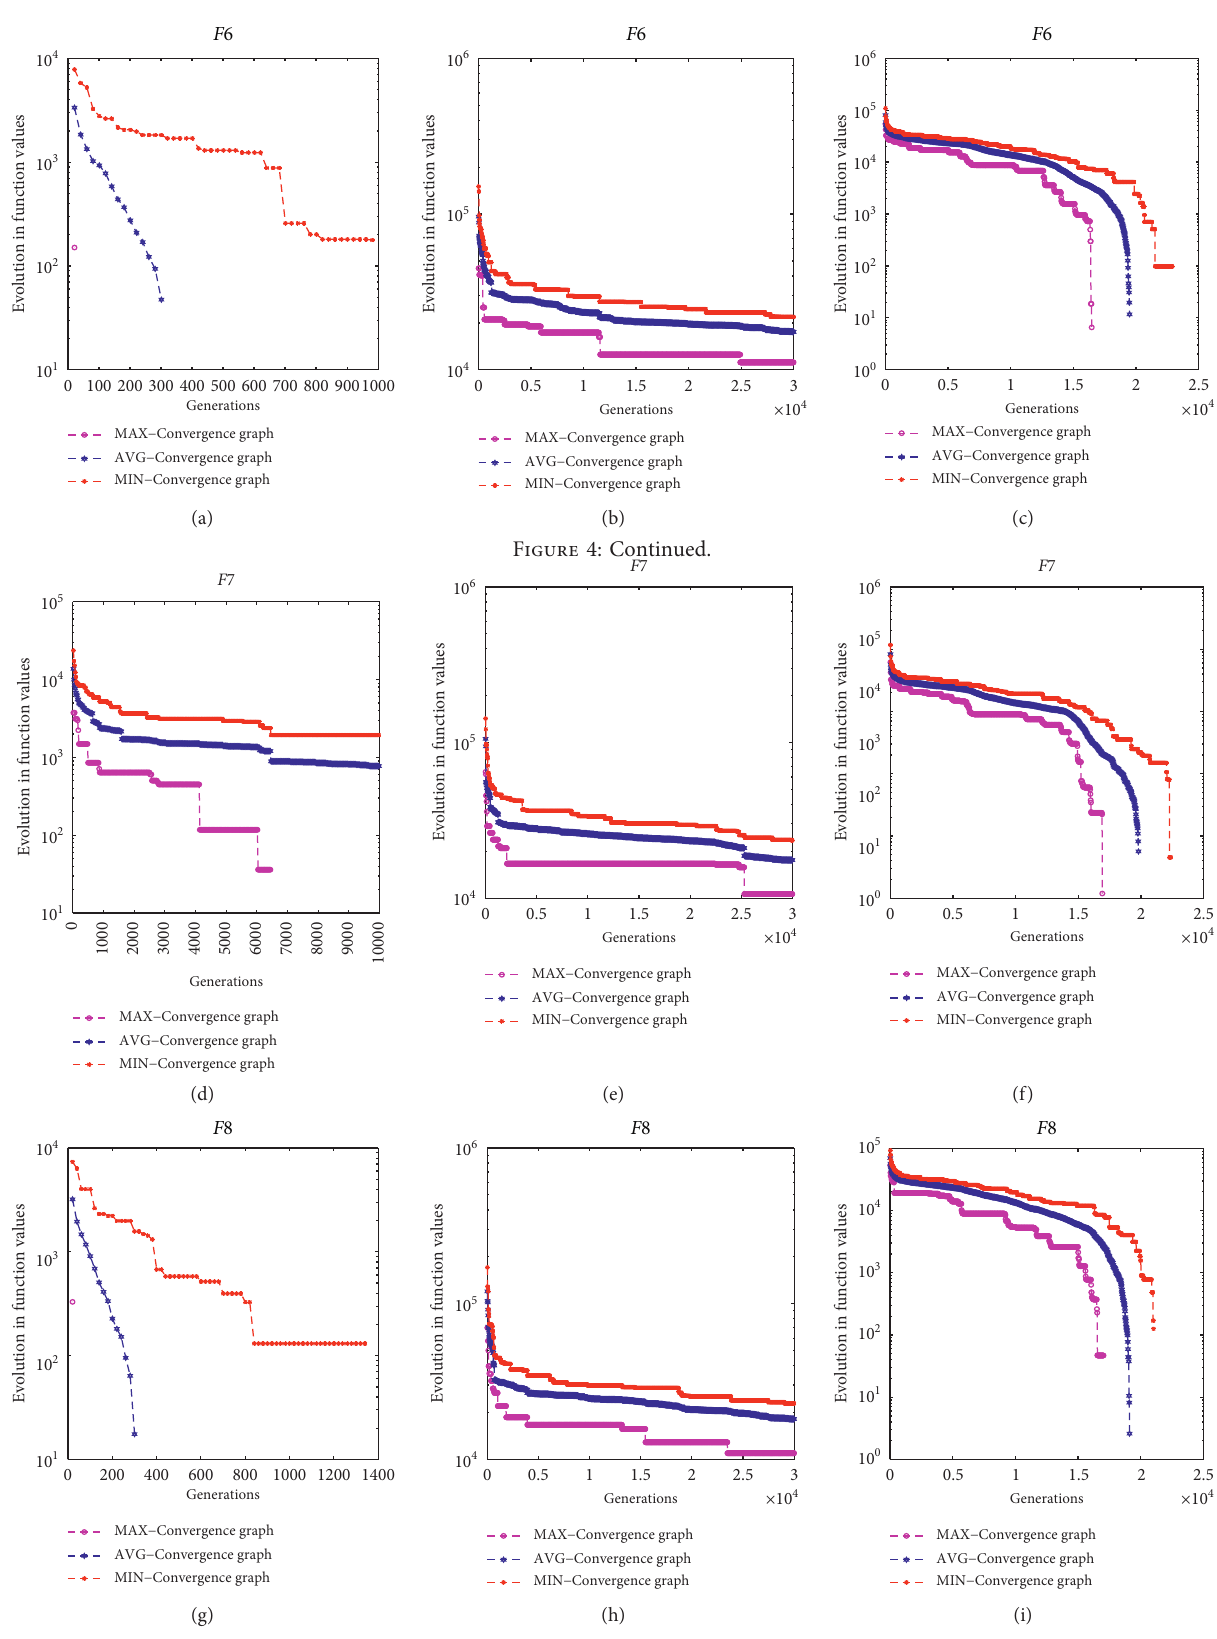
Figure 4: The evolution in maximum, average, and minimum function values displayed by the proposed MSIA solving the benchmark to F [54]. The first panel shows the convergence graph with respect to n � 10, the second panel is with respect to n � 30, functions from F 6 8 and the third panel is with respect to n � 50 decision